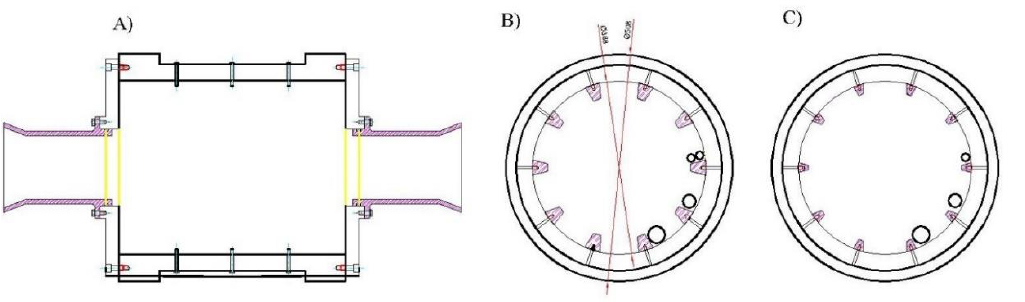
Figure 2. Laboratory tumbling rod mill design. ( A ) Profile view, ( B ) 35 mm lifter height configuration, ( C ) 23 mm lifter height configuration. Table 2. Main features of the laboratory tumbling rod